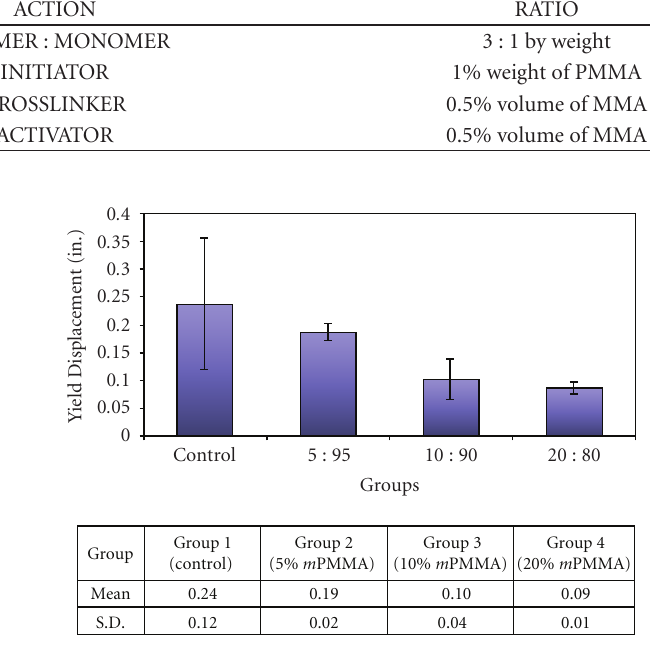
Figure 1: The bar graph represents the mean and standard deviation values for transverse strength or force at fracture for each of the experimental groups.